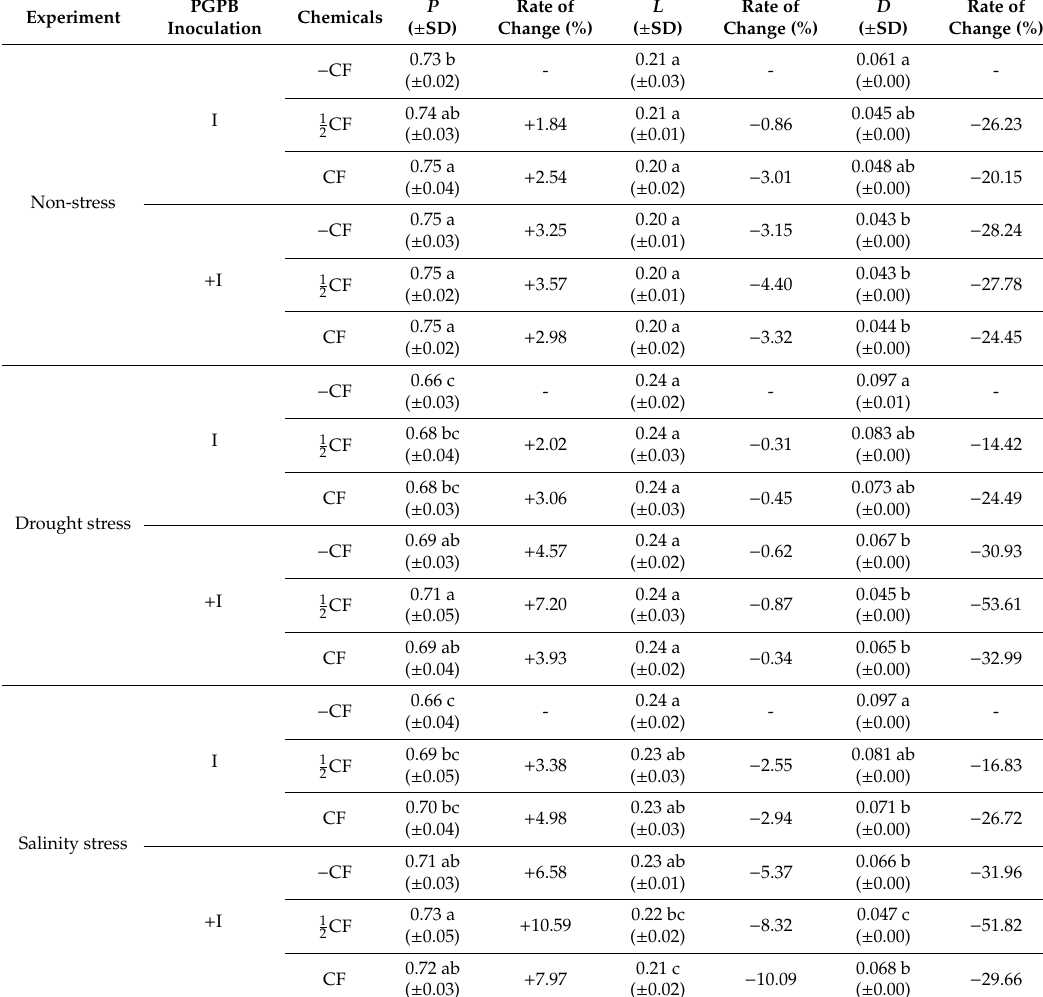
Table 2. Estimation of fraction of light absorbed by PSII that is used in photochemistry ( P ); quantum yield of thermal dissipation in the dark-adapted state ( L ) and quantum yield of thermal dissipation in the light-adapted state ( D ) in response to the chemical / microbiological fertilization management under non-stress, drought and salinity conditions, as well as their change rates as compared to the non-fertilized